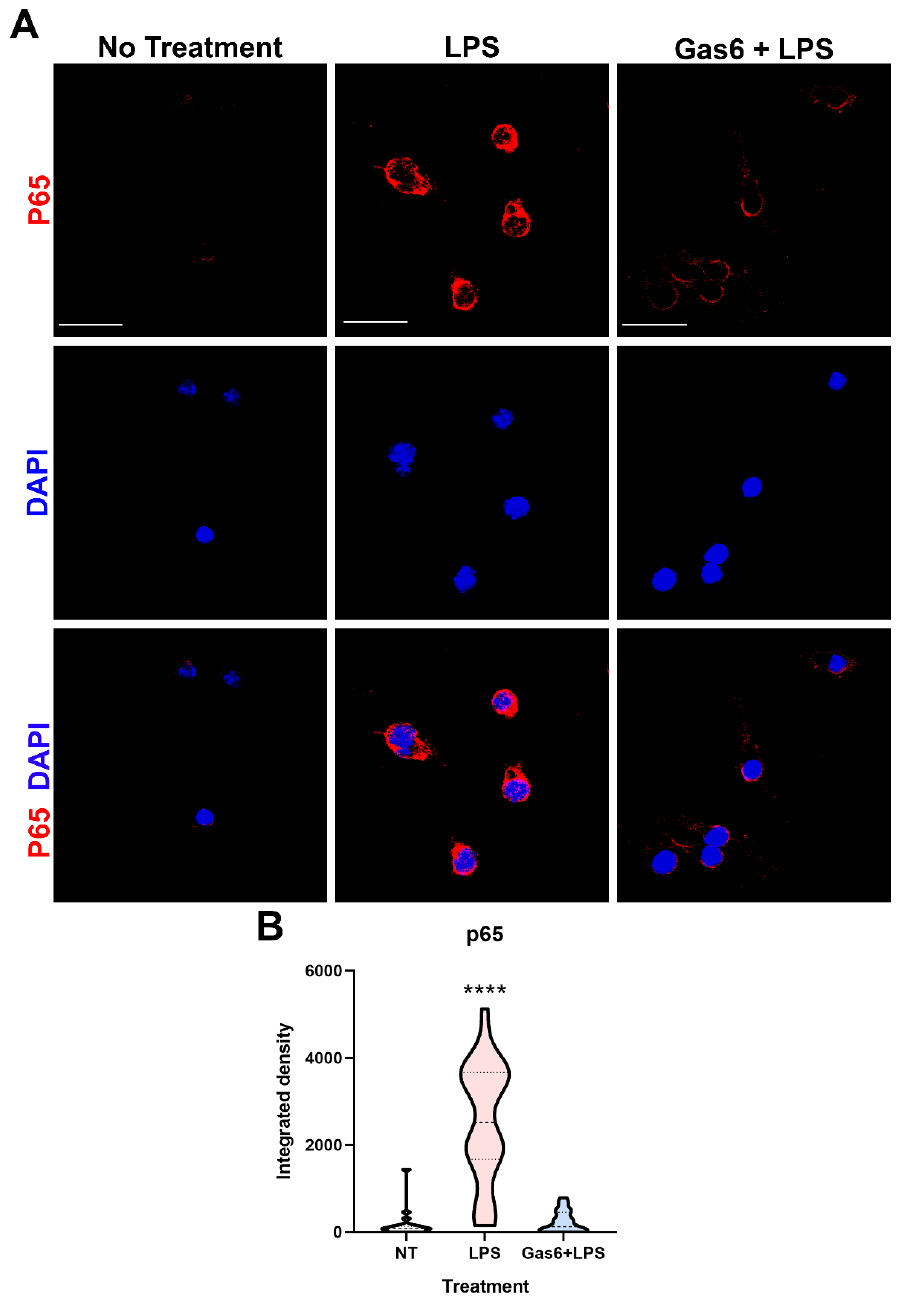
Figure 5. Gas6 inhibits LPS-induced nuclear translocation of the NF- κ B p65 subunit in microglia. Pure microglial cell cultures were treated with LPS (10 ng/mL) for 30 min with or without 1 h pre-incubation with Gas6 (1.6 µ g/mL), which then remained throughout. ( A ) Cells underwent immunofluorescence staining with anti-p65 primary antibody with AlexaFluor647 anti-mouse sec- ondary antibody and DAPI nuclear counterstaining. Scale bar = 100 µ m. ( B ) p65 staining within the nuclear area of each cell was quantified for each treatment group. Data is shown in a violin plot with median and interquartile ranges visible ( n > 30 cells). Data was statistically analysed using one-way ANOVA; **** p < 0.0001 vs. both other